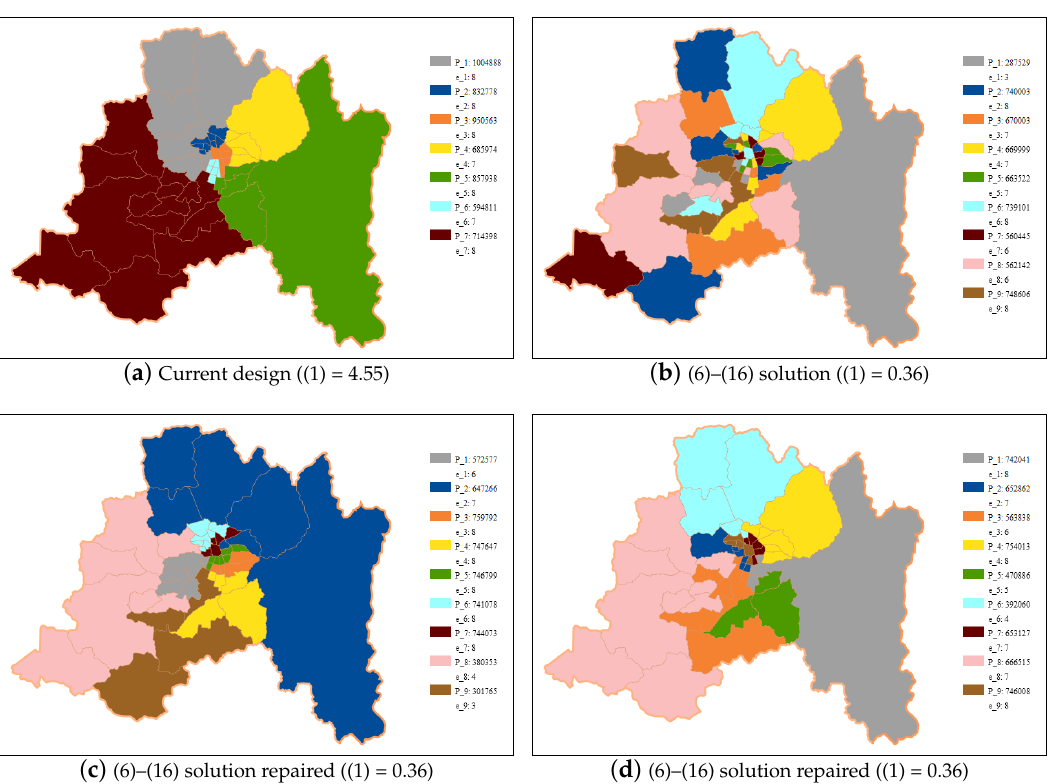
Figure 1. Comparison of districting designs for Region